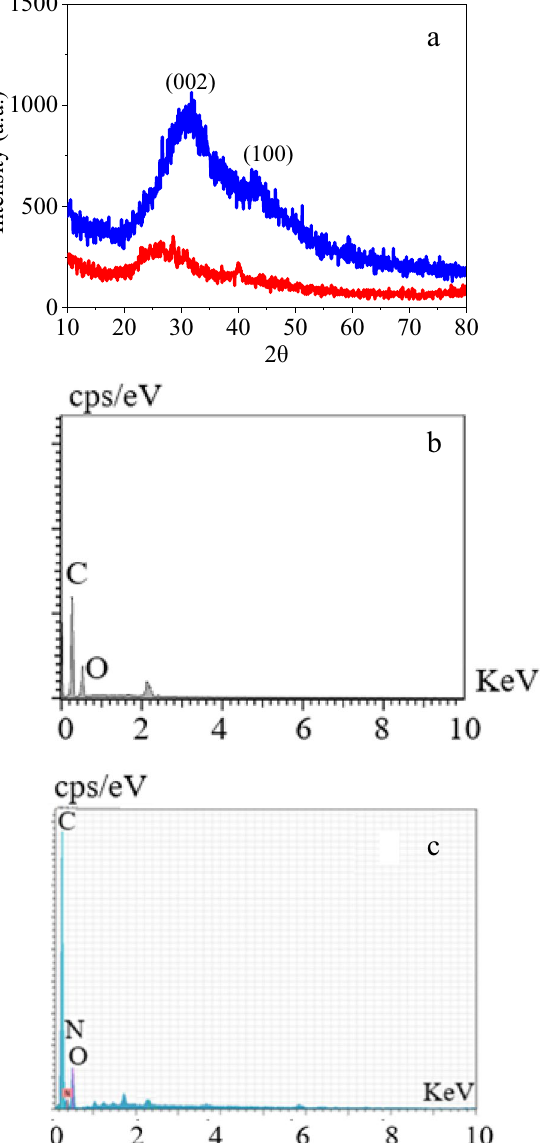
Figure 3. XRD patterns of RGO (red) and l-Arg-RGO (blue) ( a ); EDX spectrum of RGO ( b ), and l-Arg-RGO ( c